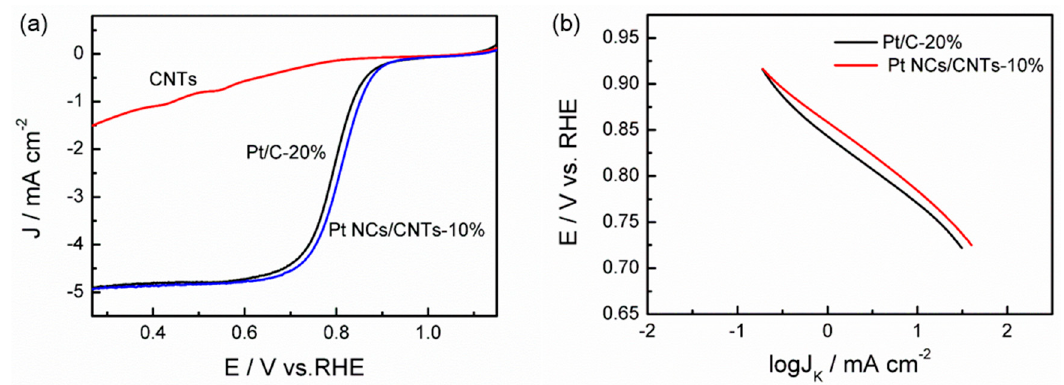
Figure 6. ( a ) Comparison of RDE polarization curves of Pt NCs/CNTs-10% and Pt/C-20% at 1600 rpm in O 2 -saturated 0.1 M HClO 4 solution at 10 mV s –1 and ( b ) Tafel plots for ORR derived from ( a ).